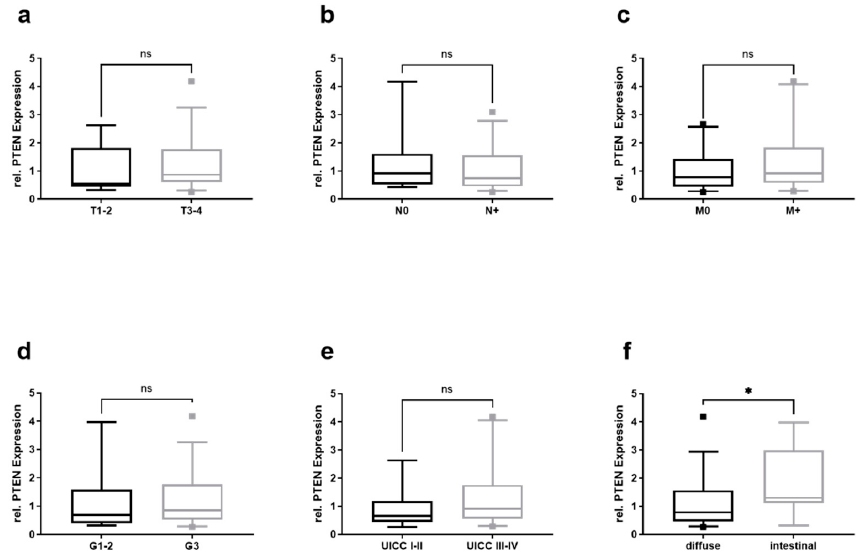
Figure 4. Relative PTEN mRNA levels in EVs from GC patients and their clinico-pathological stratifica- tion. Total RNA amount in ( a ) T1–2 and T3–4 gastric cancers, ( b ) nodal negative (N0) and nodal positive (N+), ( c ) non-metastasized (M0) and metastasized (M+), ( d ) grade 1–2 (G1–2) and grade 3–4 (G3–4),